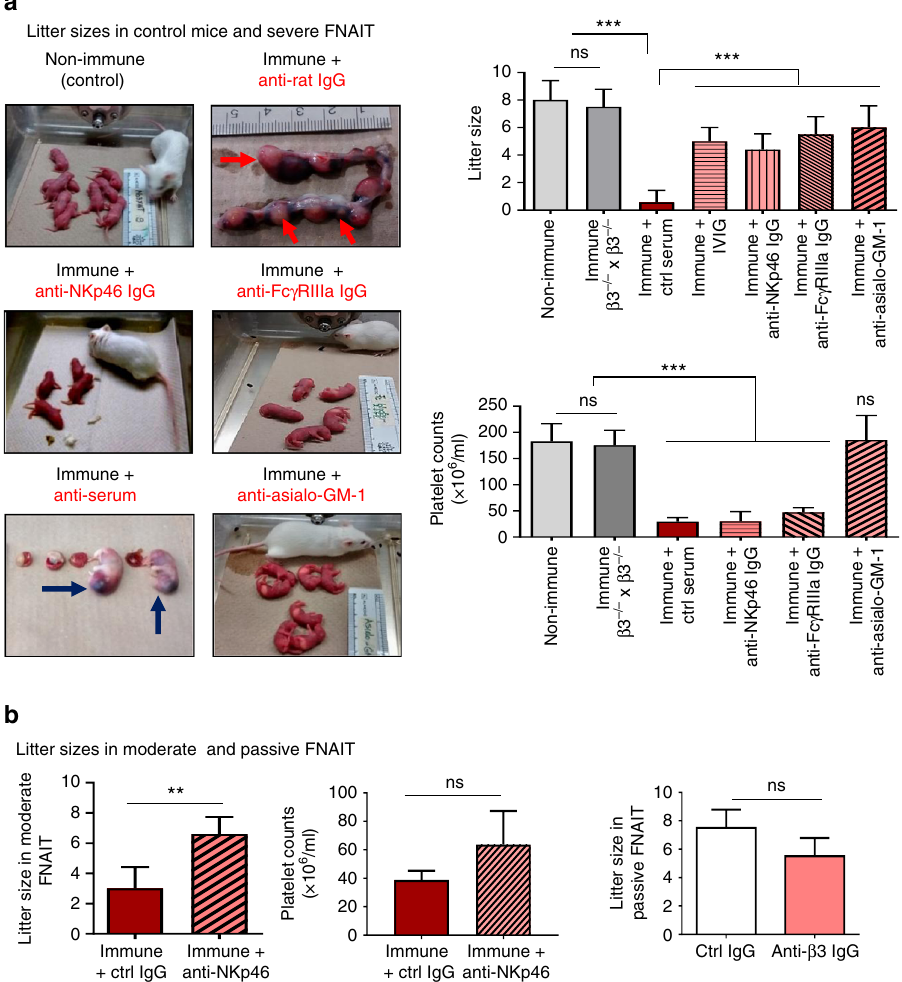
Fig. 6 Inhibition of activating receptors and NK cell depletion prevent IUGR/fetal death. a Non-immune mice had normal pregnancies and delivered healthy pups. Litter sizes were not affected in immune females mated by β 3 − / − males. In immune mice, miscarriages ( red arrows , resorbed fetuses) were frequent as well as severe bleeding in neonates ( blue arrows for ICH) and low neonatal platelet counts. NK cell depletion induced by anti-asialo-GM-1 serum prevented miscarriages and bleeding in neonates. Inhibition of NK cell activation through NKp46 or Fc γ RIIIa blockade or IVIG ameliorated pregnancy outcomes (litter size). b Anti-NKp46 treatment in moderate FNAIT (induced by lower dose of 10 7 platelet transfused/immunization) also prevented miscarriages. Injections of high titer anti- β 3 integrin IgG sera into non-immune mice did not cause miscarriage, albeit some neonates developed bleeding and ICH. Data were collected in four to eight pregnancies per group. Unpaired Student ’ s t -test ( b ); two-way ANOVA followed by Bonferroni post hoc